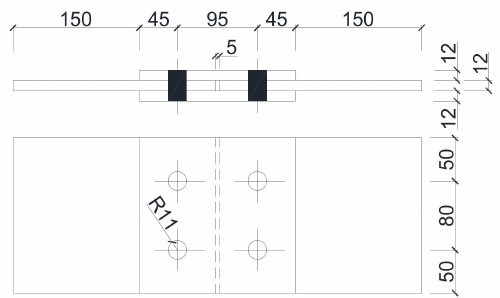
Figure 2. High-strength bolts connection (TY series).